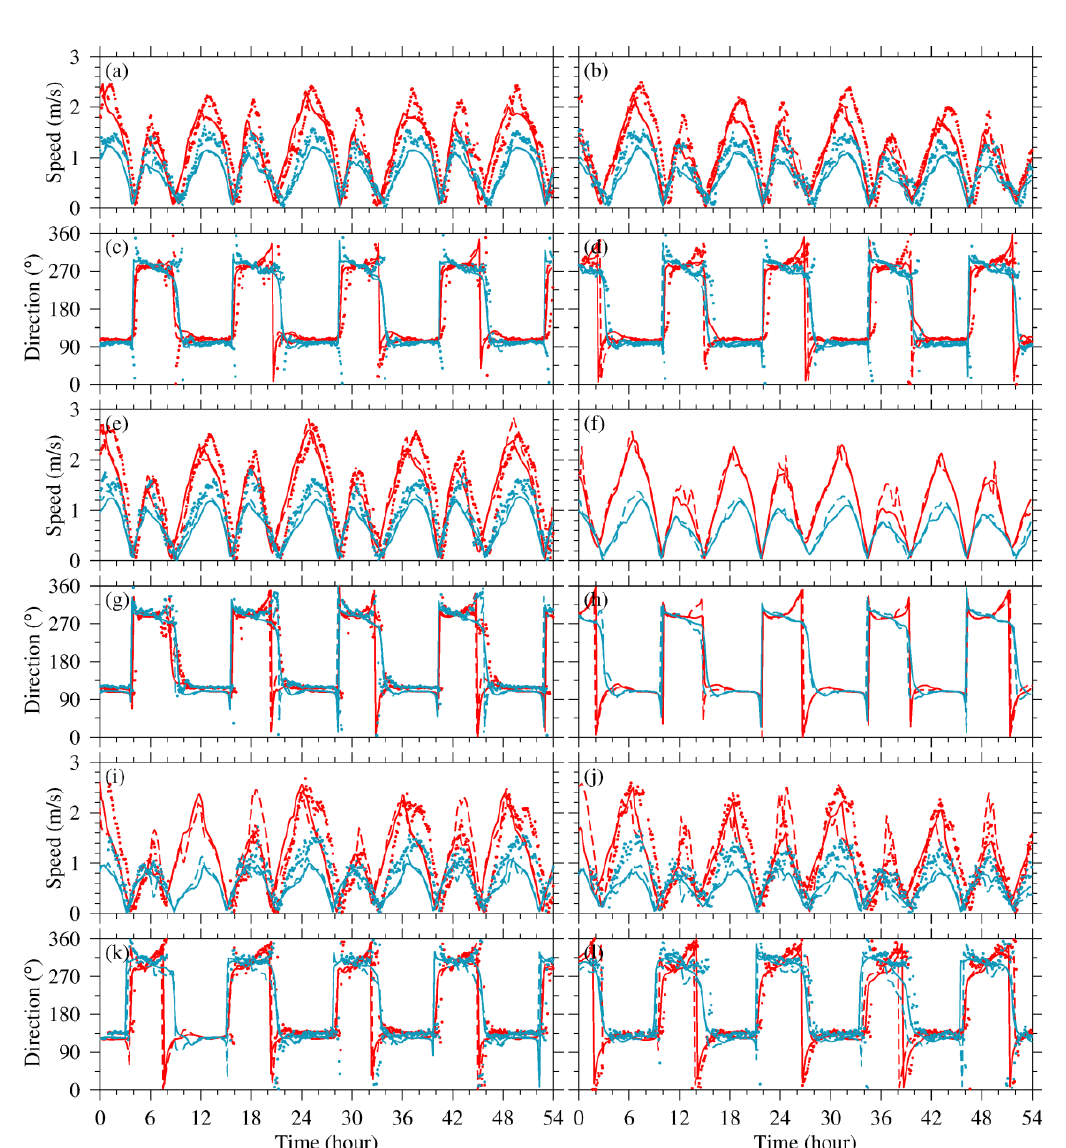
Figure 10. Time series of flow velocity and direction obtained from the observed data (dots), Exp. 0 (solid lines) and Exp. 3 (dashed lines) at sites A ( a – d ), B ( e – h ), and C ( i – l ) during spring tide (left panel) and the MTAS (right panel). Red indicates surface and blue indicates bottom. (The observed data were missing at site B during the MTAS because of instrument failure.).